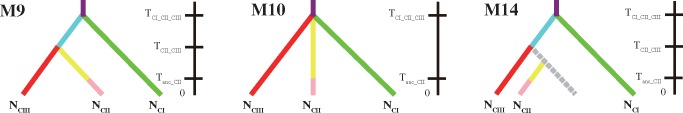
—Final models used to examine the relationships among clades of symbiotic genes. The three models are (A) simple divergence of clades such that Clade III is an ancestral lineage, (B) emergence of the three clades simultaneously, and (C) emergence of Clade II from an unsampled clade derived from Clade III. Model 10 is the most likely of the three models, with a posterior probability (PP) of 0.89.